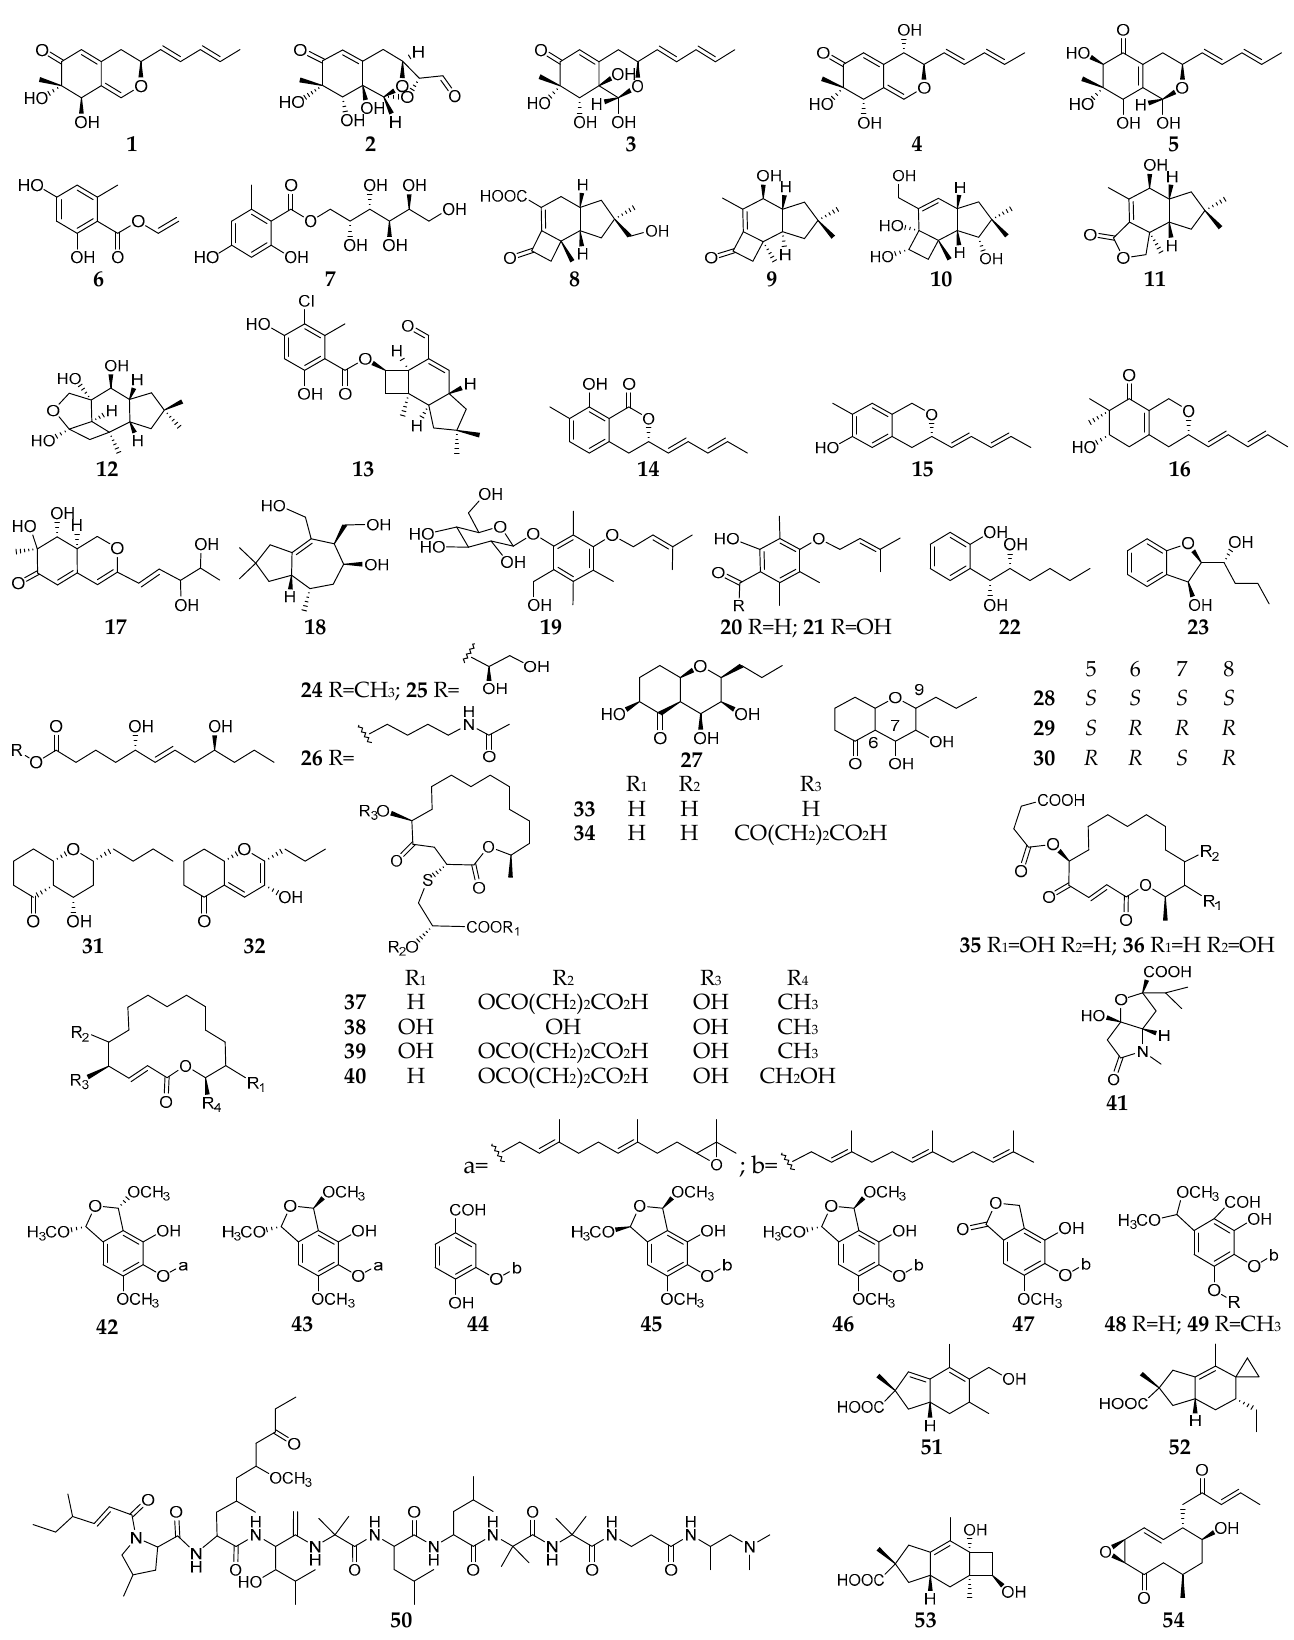
Figure 2. New SMs ( 1 – 54 ) isolated from fungal–fungal co-cultures using PDB.